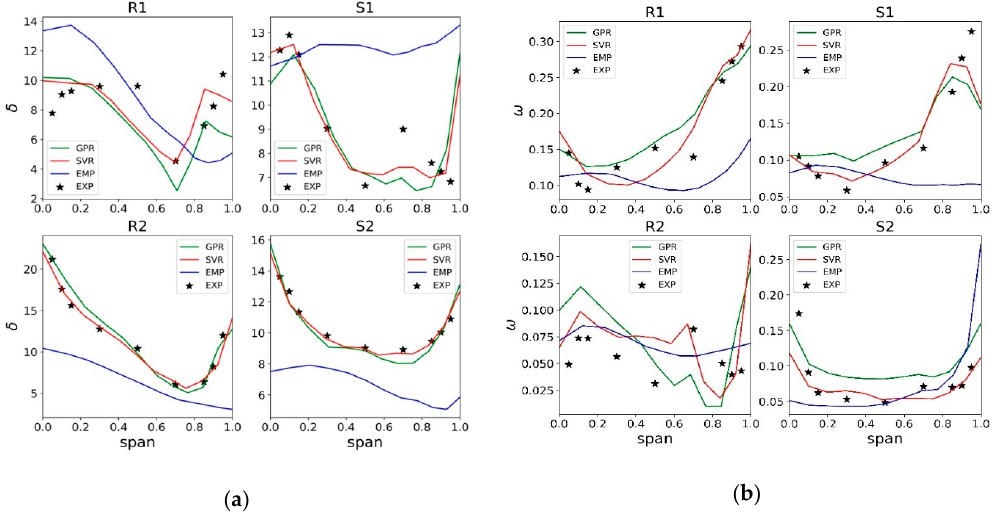
Figure 15. Spanwise distribution of predictions: ( a ) Deviation angle; ( b ) Total pressure loss. The predicted errors relative to experimental data at hub, mid-span and tip blade span are listed in Table 7 for comparing the accuracy of EMP, GPR, and SVR models. For intuitive comparison, RMSE are also calculated for each blade row as the criteria. Although the EMP model produces a lower predicted error at a few local parts, GPR and SVR models have a lower RMSE for both deviation angle and loss predictions, except the loss predictions for R2. Table 7. Prediction errors at hub (0.05) middle (0.5) and tip (0.95) span location and RMSE. Row